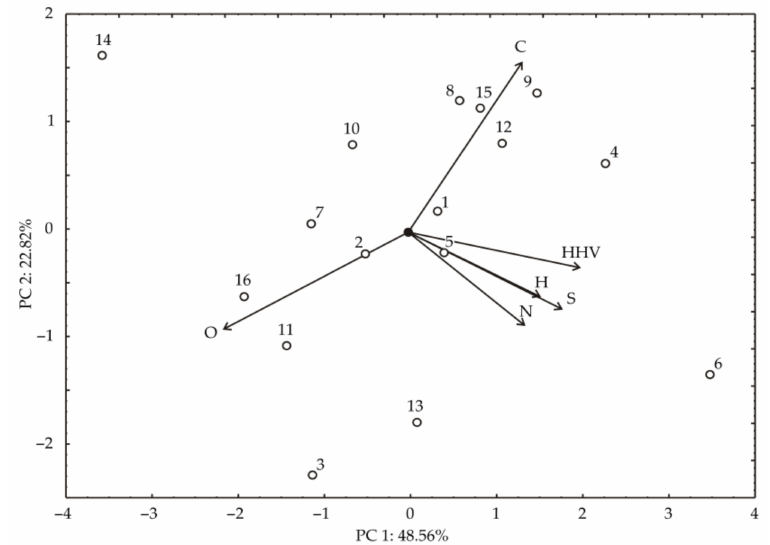
Figure 3. PCA of observed values.